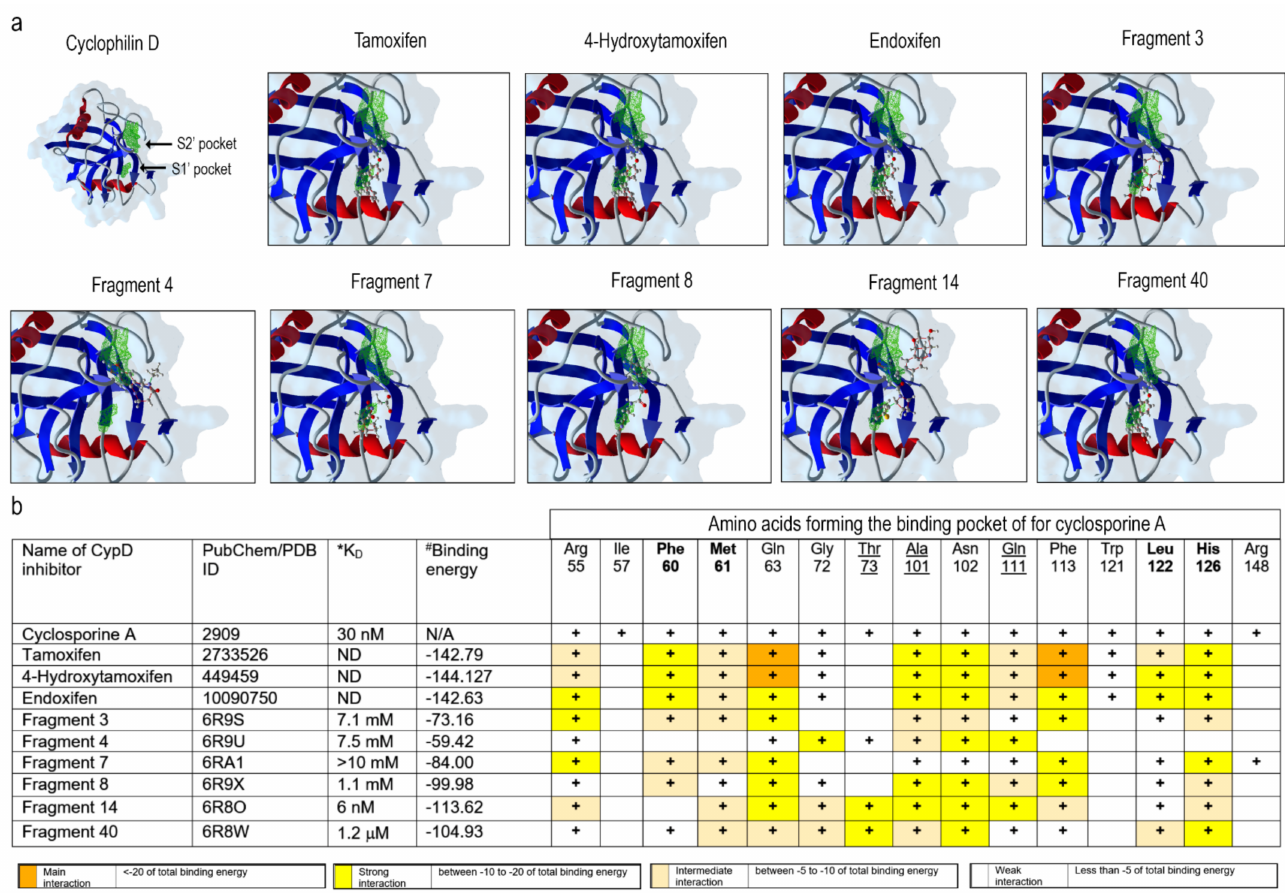
Figure 3. In silico evaluation of the molecular interactions of human CypD with TAM, TAM derivatives or CypD nonpeptidic inhibitors. ( a ) Structure of CypD (Left; PDB: 2Z6W), green shadowed regions represent the S1 (cid:48) and S2 (cid:48) pockets of human CypD. Predicted interactions and orientation of selected ligands within CypD are drawn. ( b ) Summary of the obtained interaction energy values (MolDock Score), in vitro dissociation constant values (from [45]) and CypD residues’ binding contributions for different ligands. (+) implies that amino acid is involved in binding. Different strengths of interaction are color coded. * determined from surface plasmon resonance (SPR) and protein-based NMR studies. # Energy from interactions predicted by the docking analysis (Epair from MolDockScoring). Bold residues are part of the CypD active site and S1 (cid:48) pocket. Underlined residues are part of the active site of CypD and the S2 (cid:48)